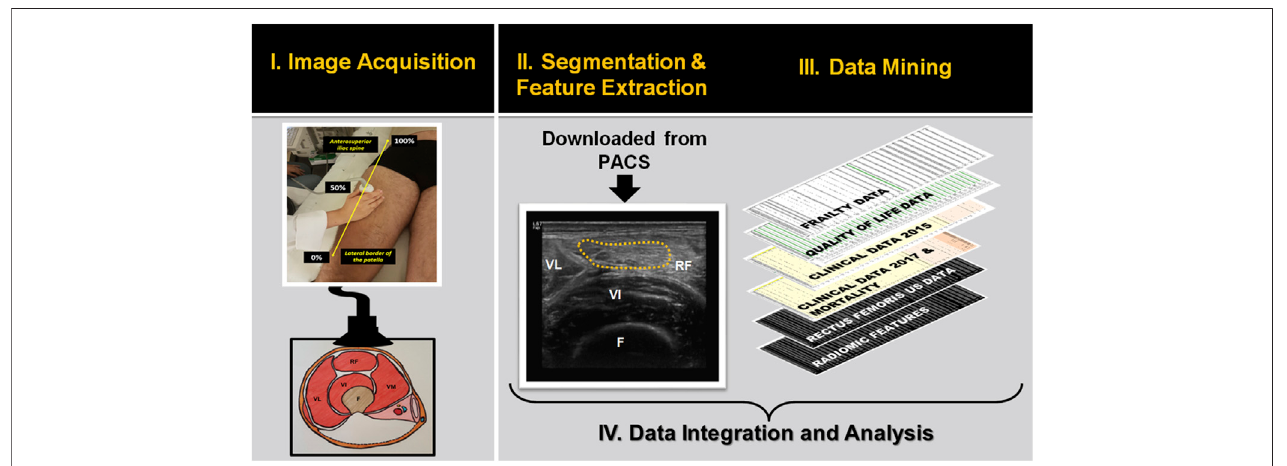
FIGURE 1 | Flowchart showing the main steps for developing descriptive and prognostic image-based phenotyping using radiomic features extracted from ultrasound images. Abbreviations: MT: muscle thickness; VL: Vastus lateralis; RF: rectus femoris muscle; VI: vastus intermedius; F: Femur; PACS: Picture archiving and communication